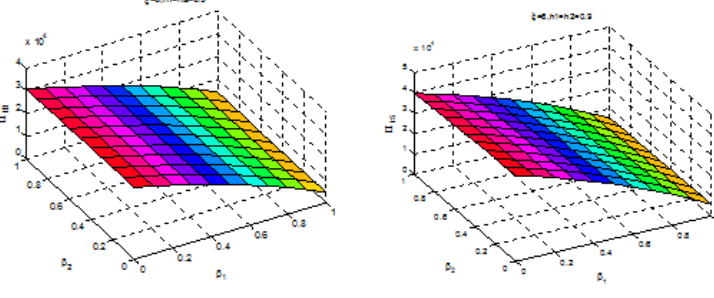
Figure 6. The change of the optimal profits with the return price in two games